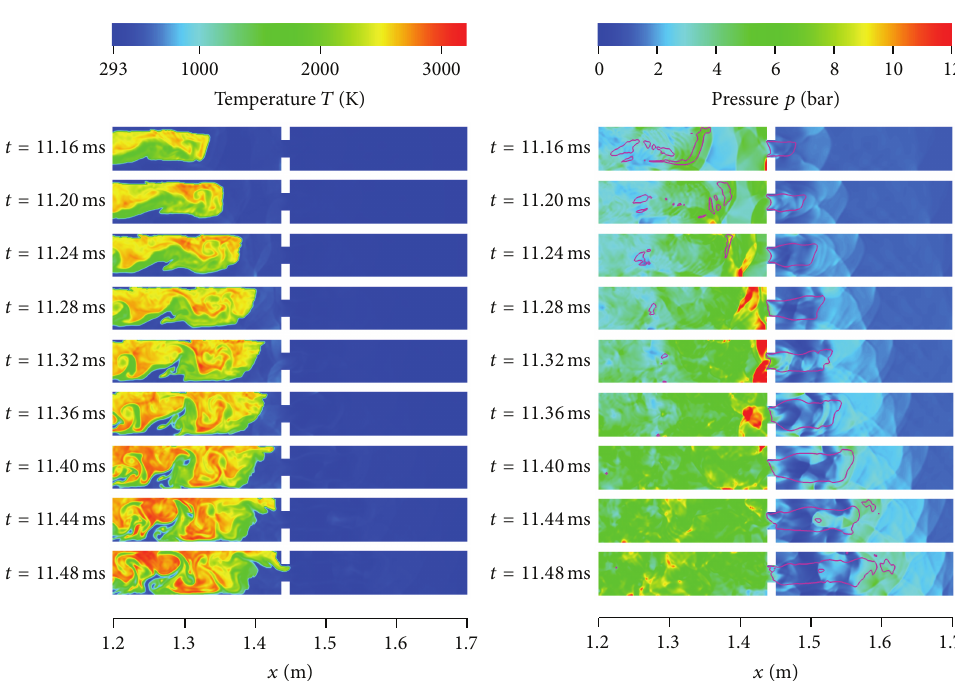
Figure 13: Shock-flame interaction at an obstacle of blockage ratio 60%. The pink contour shows the Ma = 1 line.